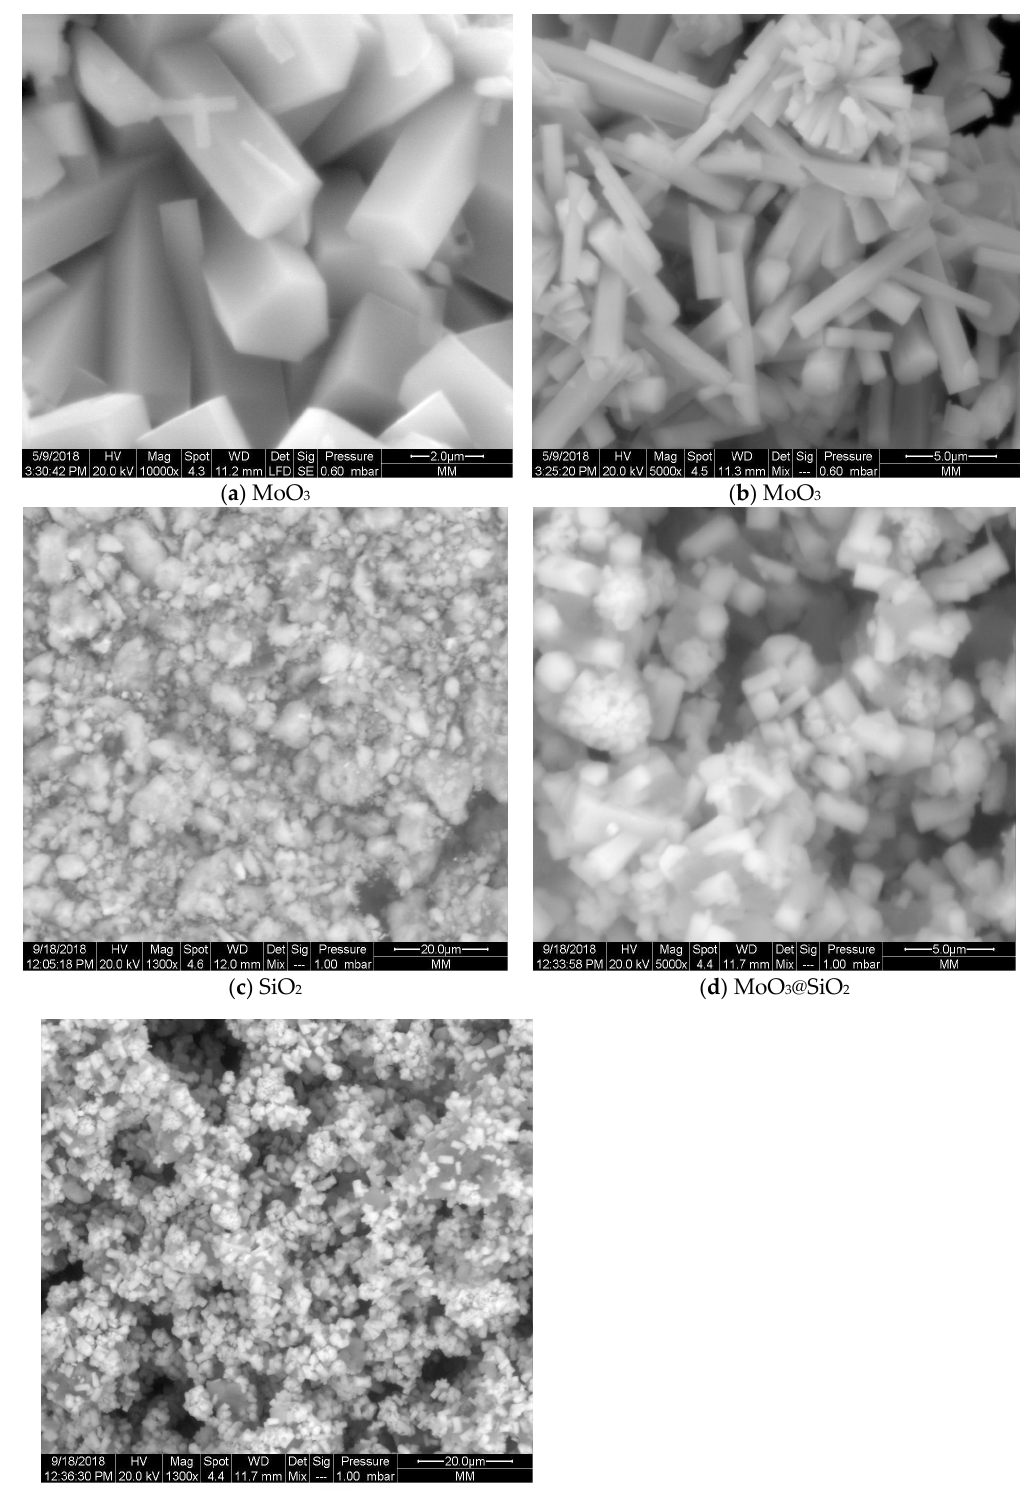
Figure 3. SEM micrographs of MoO 3 nanoparticles ( a , b ), silica particles ( c ), and MoO 3 @ SiO 2 nanoparticles composites ( d , e ) at different magnifications.